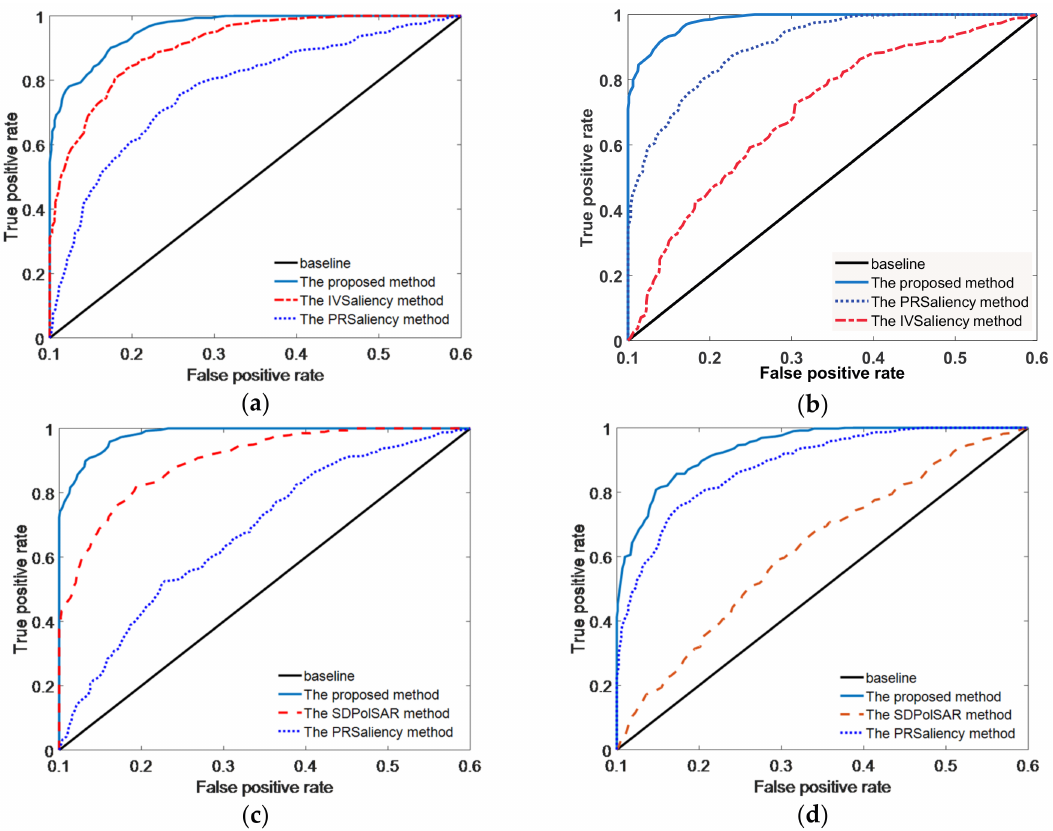
Figure 13. Receiver operating characteristic (ROC) curves of various methods using different datasets. ( a ) X-band SAR image; ( b ) Sentinel-1 C-band SAR image; ( c ) Radarsat-2 C-band PolSAR image; ( d ) UAVSAR L-band PolSAR